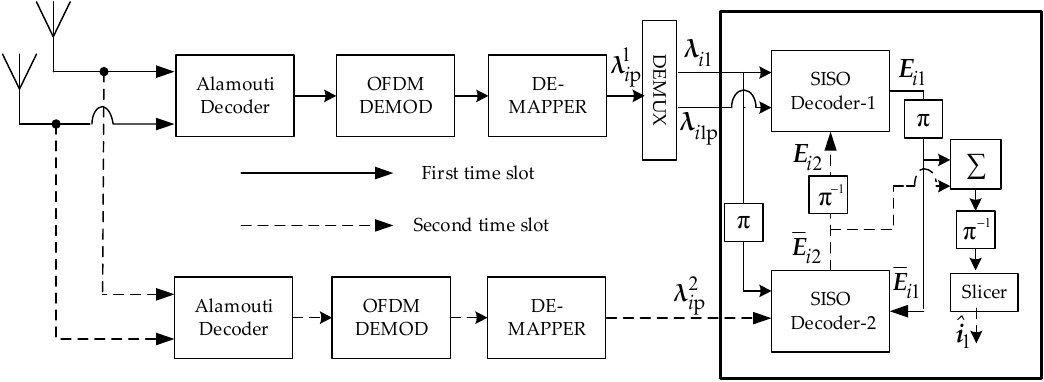
Figure 6 . Joint iterative SISO decoding for turbo coded OFDM with MIMO (2 × 2) antennas. Figure 6. Joint iterative SISO decoding for turbo coded OFDM with MIMO (2 × 2)